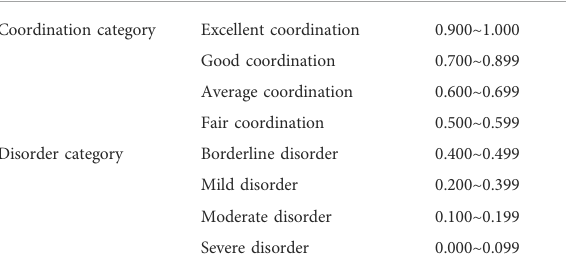
TABLE 3 Divisions of the strength categories of “ livelihoods – environment ” links. Division categories Subdivision categories Link